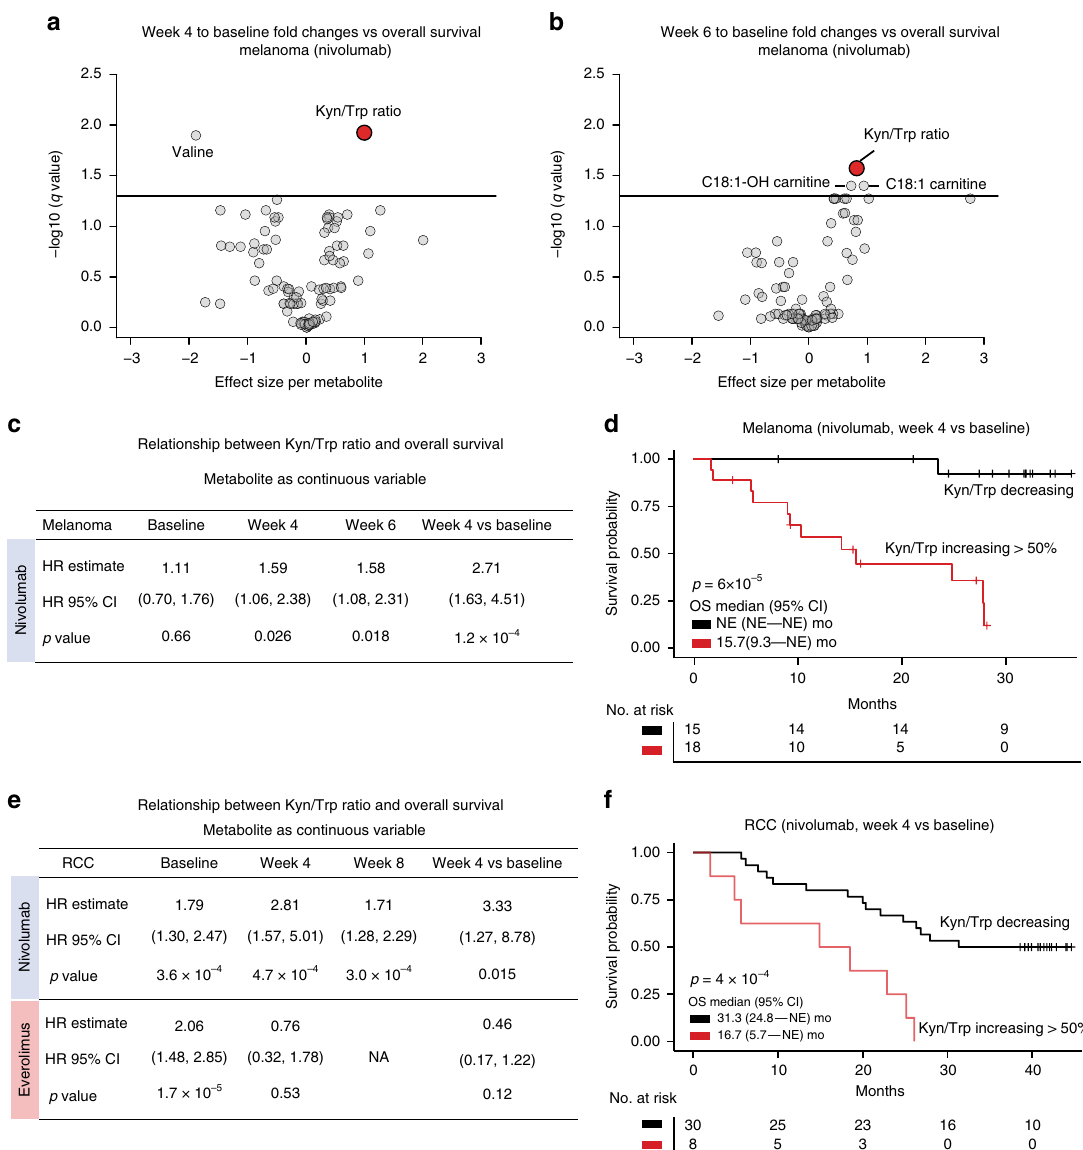
Fig. 3 Kyn/Trp ratio alterations associate with patient overall survival in two independent cohorts. a , b Volcano plots showing associations between fold changes (log2 scale) of different serum metabolites ( n = 106) and overall survival in melanoma patients. The effect sizes refer to the regression coef fi cients in a Cox proportional hazards model and the points represent different metabolites. a 4 weeks after nivolumab treatment versus baseline, b 6 weeks after nivolumab treatment versus baseline. q values were calculated using Benjamini-Hochberg multiple testing corrections. A cutoff at q = 0.05 is shown as a horizontal line. c Table summarizing the hazard ratios (HR) of Kyn/Trp (log2 scale) as a predictor at different time points in relation to melanoma patient overall survival using a Cox proportional hazards model. CI, con fi dence interval. d Kaplan – Meier plot comparing the overall survival in melanoma patients with >50% increases in Kyn/Trp ratios versus those with decreases. e , Table summarizing the hazard ratios (HR) of Kyn/Trp (log2 scale) as a predictor at different time points in relation to CheckMate 025 RCC patient overall survival using a Cox proportional hazards model. f Kaplan – Meier plot comparing the overall survival in RCC patients with >50% increases in Kyn/Trp ratios versus those with decreases. The p values in d , f were based on log-rank